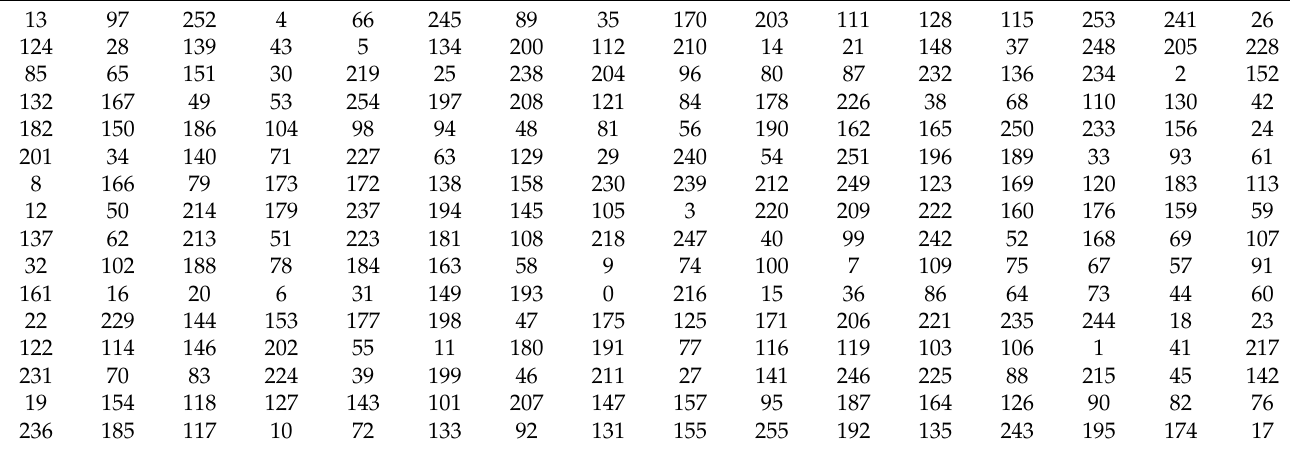
Table 3. Proposed S-box